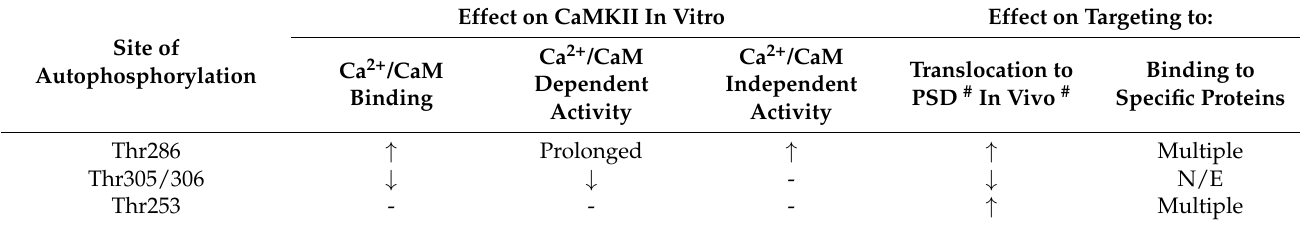
Table 1. Effects on CaMKII activity and targeting following autophosphorylation at threonine (Thr) 253, 286 and